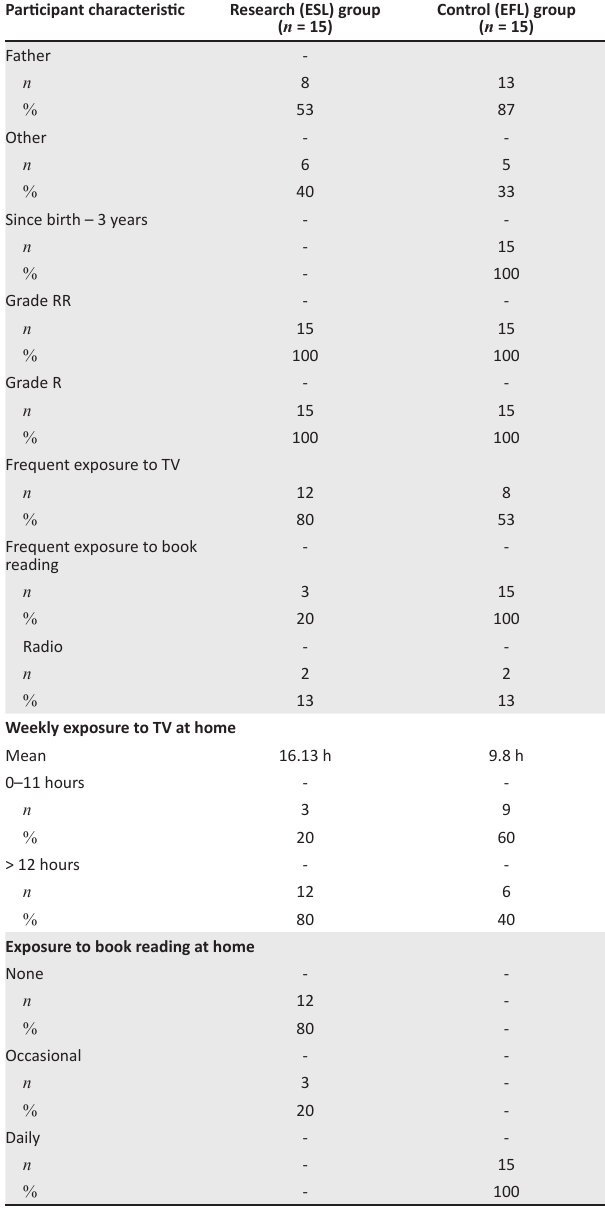
TABLE 1 (Continues...): Grade 1 participant characteristics ( n =